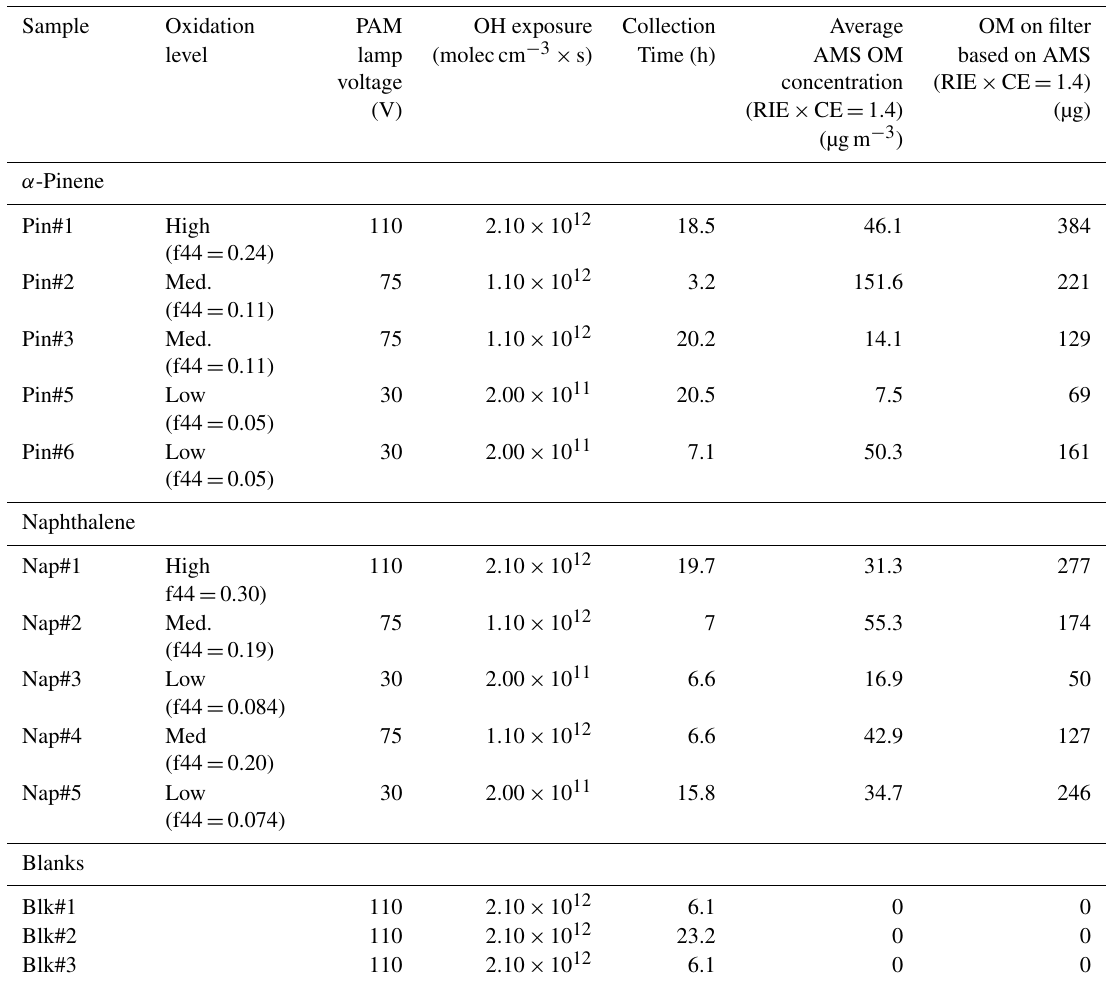
Table 1. PAM experimental conditions for naphthalene and α -pinene SOA ageing studies. Sample Oxidation PAM OH exposure Collection Average OM on filter level lamp (moleccm − 3 × s) Time (h) AMS OM based on AMS voltage concentration (RIE × CE = 1.4) (V) (RIE × CE = 1.4) (µg) (µgm − 3